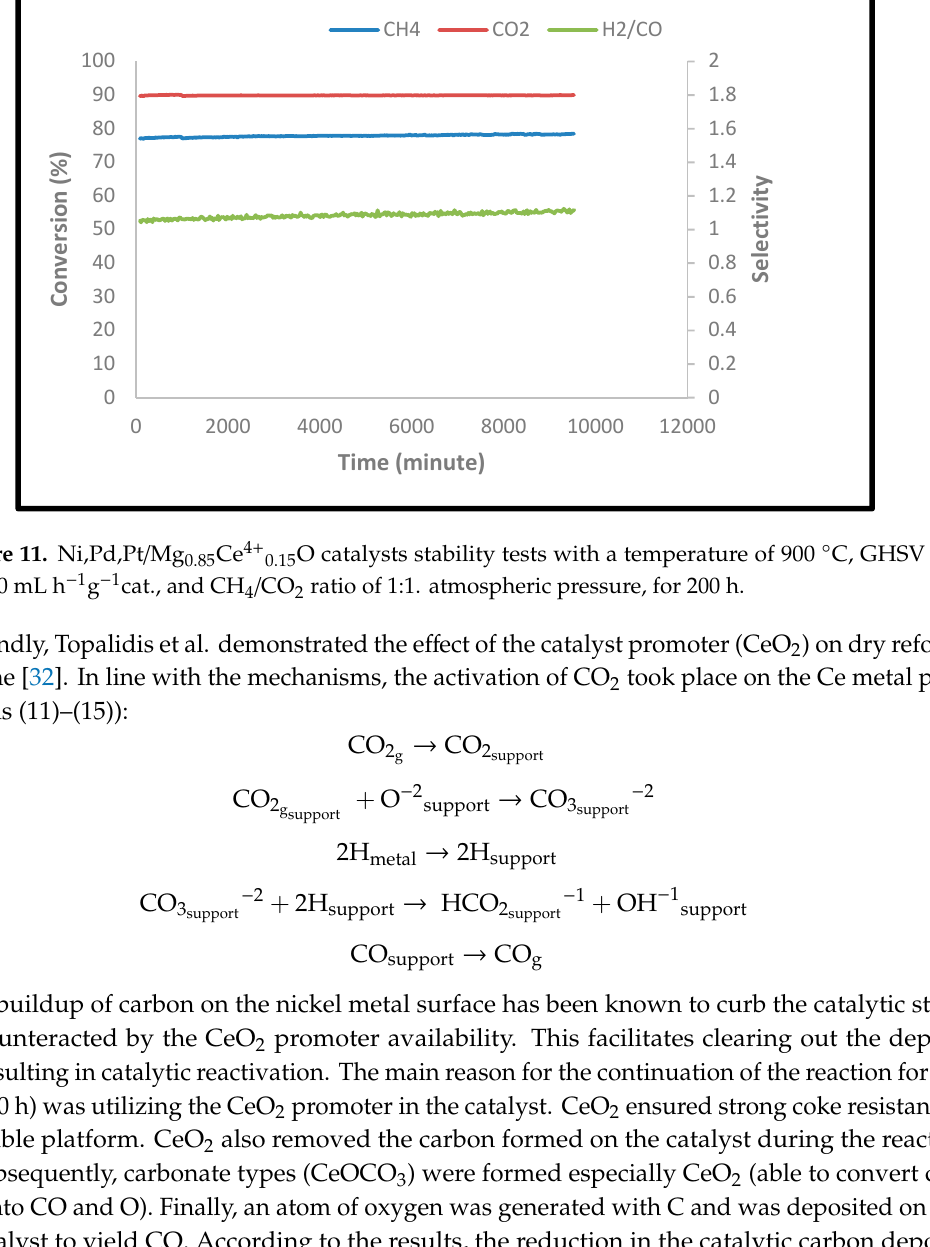
illustrates the H 2 selectivity of the DRM reaction using Ni,Pd,Pt / + Mg 0.85 Ce 4 0.15 O